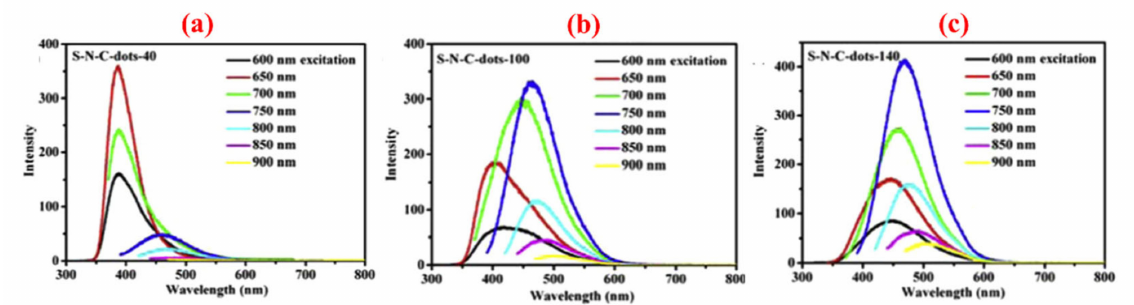
Figure 11. Upconversion photoluminescence properties of S-N-co-doped C-dots obtained from hair fiber under di ff erent conditions. ( a ) 40 ◦ C; ( b ) 100 ◦ C; ( c ) 140 ◦ C [117].